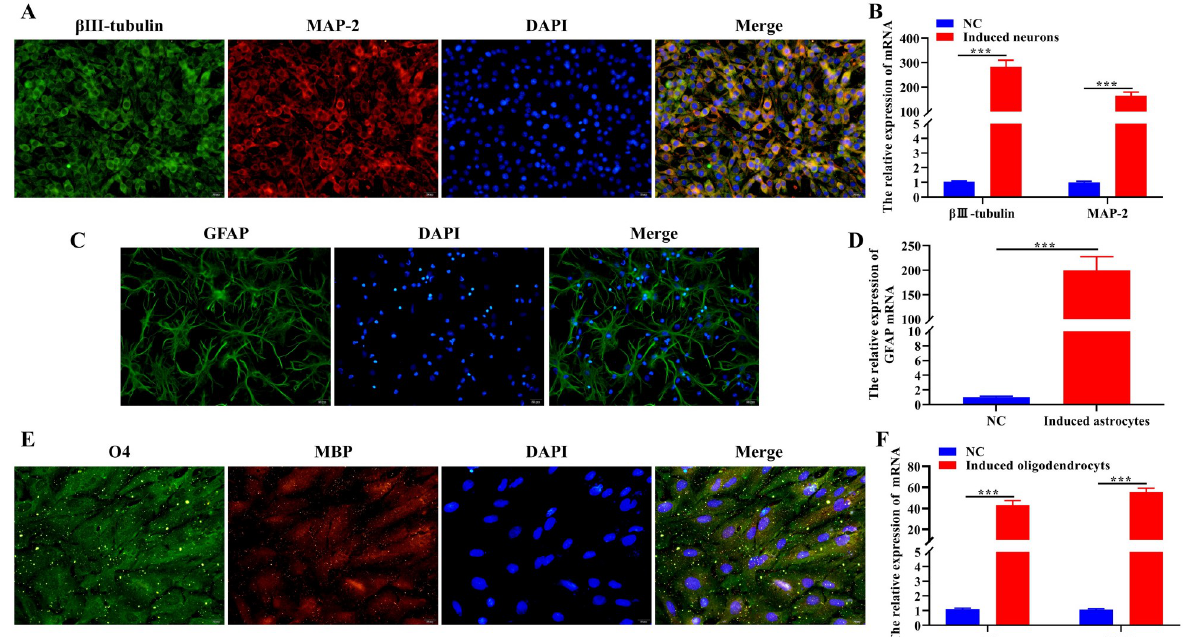
Fig 2. BMSCs were induced to differentiate into neurons, astrocytes and oligodendrocytes. Respectively, 21 days after the induction of BMSCs, IF staining was performed to detected the position and level of (A) neurons (MAP-2 and β III-tubulin), (C)astrocytes (GFAP), and (E) oligodendrocytes marks (MBP and O4). Scale bar = 20 μ m. The expression levels of (B) MAP-2 and β III-tubulin, (D) GFAP, (F) MBP and O4 mRNA were detected by RT-qPCR. In all cases, Values are mean ± SD (n = 3 for each group; �� P < 0.01, ��� P < 0.001).